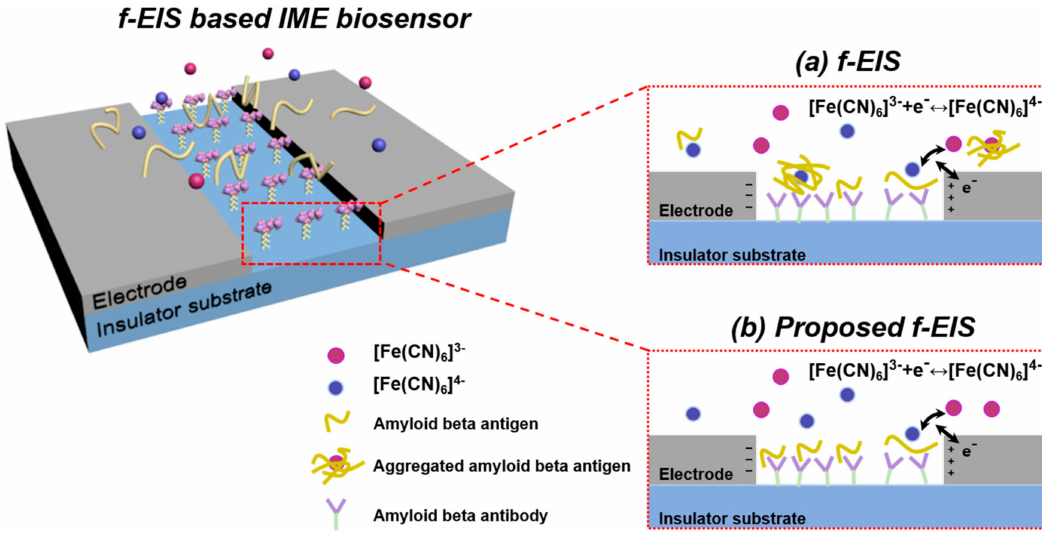
Figure 2. Schematic of A β detection in faradaic electrochemical impedance spectroscopy (f-EIS) biosensor ( a ) f-EIS ( b ) Proposed